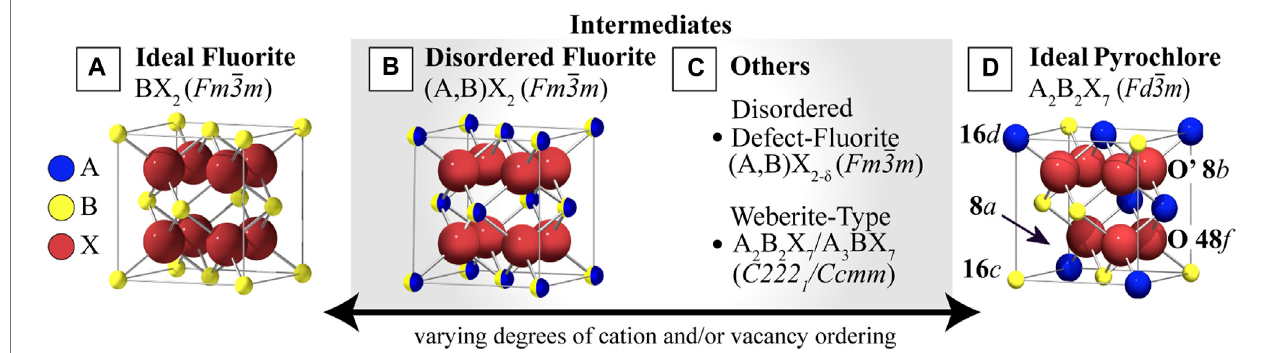
FIGURE 1 | Fluorite, Pyrochlore, and intermediate structures with varying degrees of cation and anion disorder. (A) The ideal fl uorite structure with a single cation. (B) An intermediate disordered fl uoritestructure withtwo randomly distributed cation species. (C) Otherpossible intermediates,includingthe disordered defect- fl uorite, wherebothcationsandvacanciesaredisorderedandthestructureisanion-de fi cient,andtheweberite-typestructureswithfullcationandanionorderingthatdiffersfrom the (D) ideal ordered pyrochlore structure, which has two ordered cation species and ordered structural vacancies (showing 1/8 of the unit cell). Reproduced from (Stanek, 2003; Cleave, 2006; Zhao et al.,